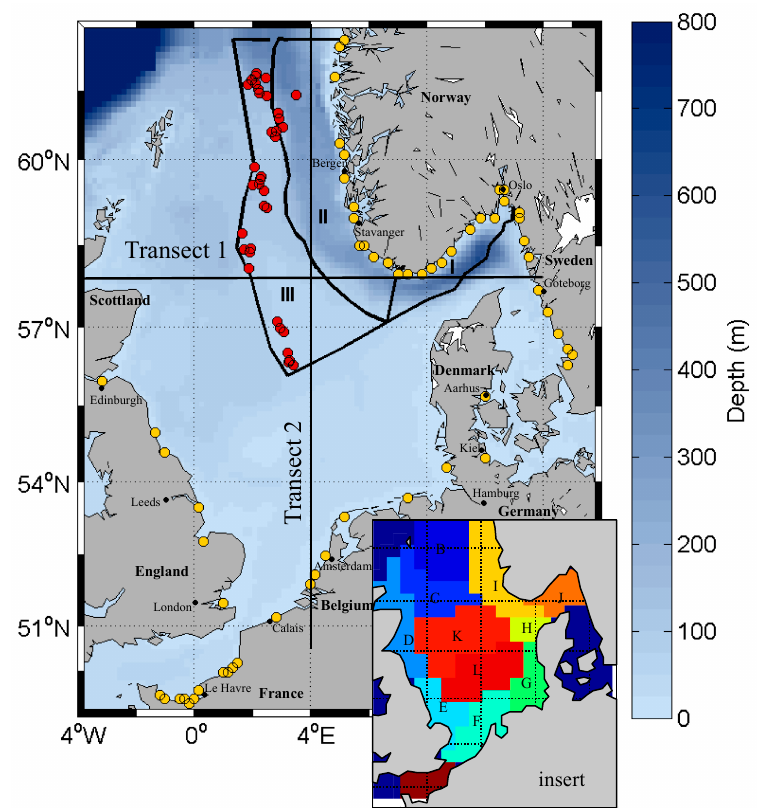
Figure 1. Model area and bathymetry, river positions (yellow dots), and Norwegian oil platform positions (red dots). Subdivision of the north-eastern North Sea in areas I–III for time series analysis (see Section 3.2) and transect locations for analysis in Section 3. Insert: area subdivision for model validation (see Section 3.1).